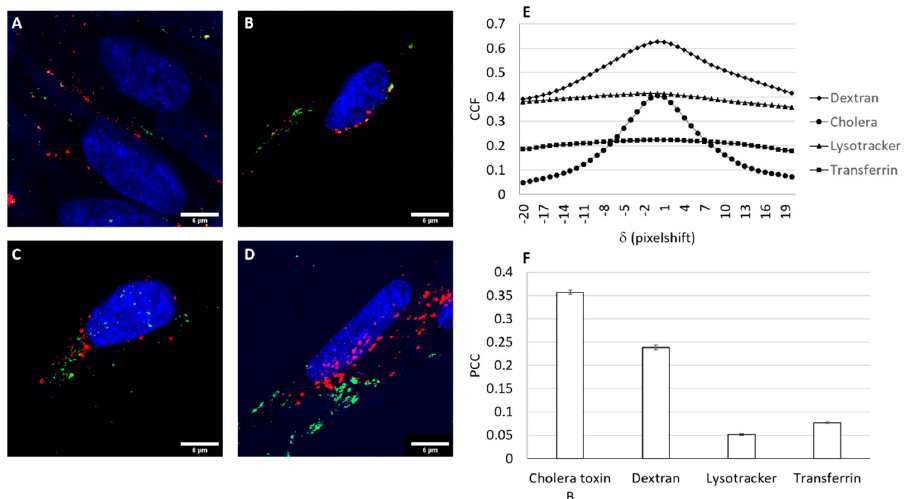
Figure 5. Endocytic and intracellular trafficking pathway detection assay of GPxT-CQ nioplexes in hUSCs. ( A – D ) Confocal microscopy merged images showing hUSCs co-incubated with GPxT-CQ nioplexes containing the FITC-labeled pCMS-EGFP plasmid (green) and the endocytic vesicle marker (red): ( A ) caveolae-mediated endocytosis (cholera toxin B), ( B ) macropinocytosis (dextran), ( C ) lysosomes (Lysotracker), and ( D ) clathrin-mediated endocytosis (transferrin). Scale bar: 6 μ m. ( E ) Cross-correlation function (CCF) of colocalization between red and green signals. Data are represented as the mean ± SEM, n = 3. ( F ) Pearson correlation coefficient (PCC) of red and green signals determined by cross-correlation analysis in each case. Data are represented as the mean ± SEM, n = 3. For interpretation of the references to color in this figure legend, the reader is referred to the web version of this article.